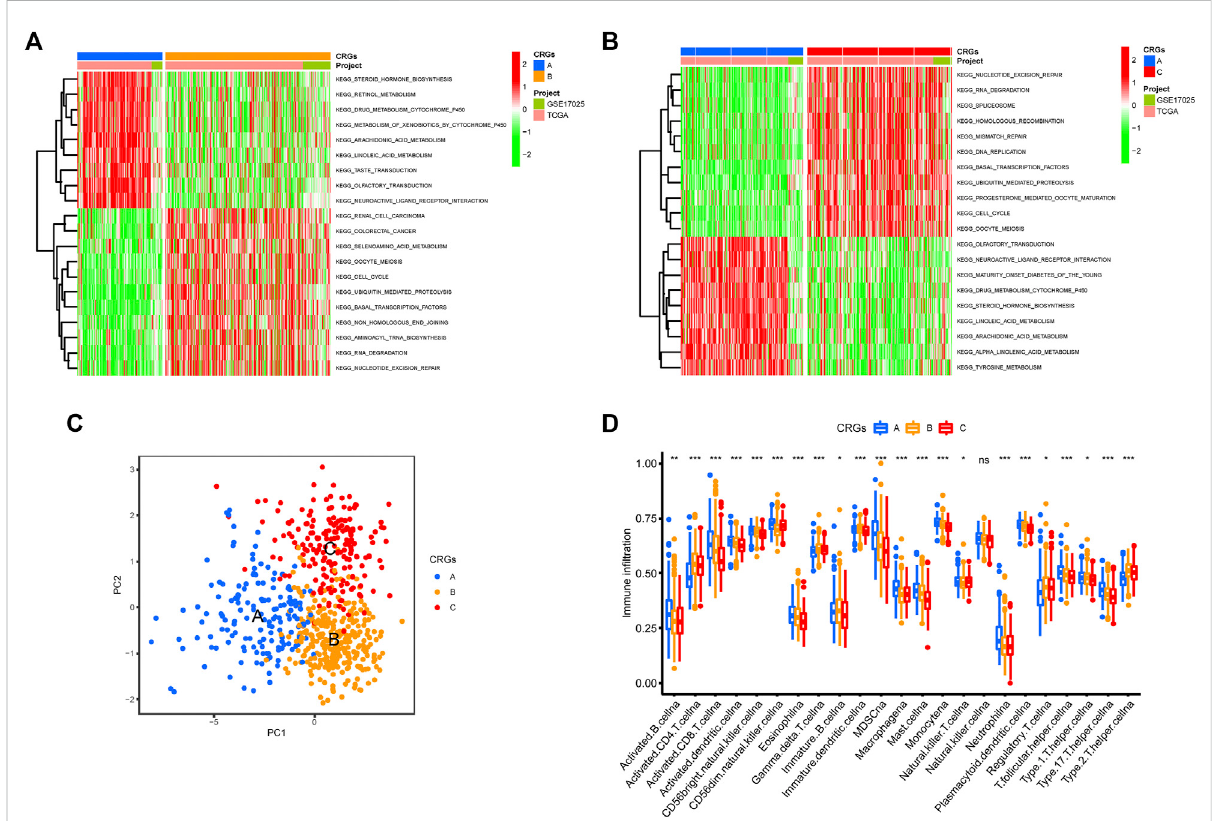
FIGURE 4 Biological pathways based on three clusters and the in fi ltrating immune cell component in TME. (A,B) The activation status of biological pathways in three CRGs clusters as depicted by GSVA enrichment analysis. The heatmap displayed in red represents activated pathways, and green represents inhibited pathways. (A) KEGG pathways of CRGs expression clusters A vs. B (B) KEGG pathways of CRGs expression clusters A vs. C. (C) Principal component analysis (PCA) shows signi fi cant differences among the three different cuproptosis patterns. (D) The expression abundance of in fi ltrating immune cells in three cuproptosis patterns. The boxplot showed the expression differences of 23 kinds of immune cells among CRGs cluster A, B, and C. The upper and lower ends of each box mean the quartile range of the value, the middle line represents the median value. The statistical p -value is shown by an asterisk (* p < 0.05, ** p < 0.01, *** p <